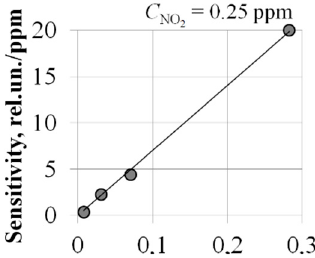
Figure 9. The dependence of the sensitivity of metal–insulator–semiconductor (MIS) sensors with the structure of Pd–SiO 2 –Si to NO 2 on the area of the Pd-gate. T MIS = 100 °C.